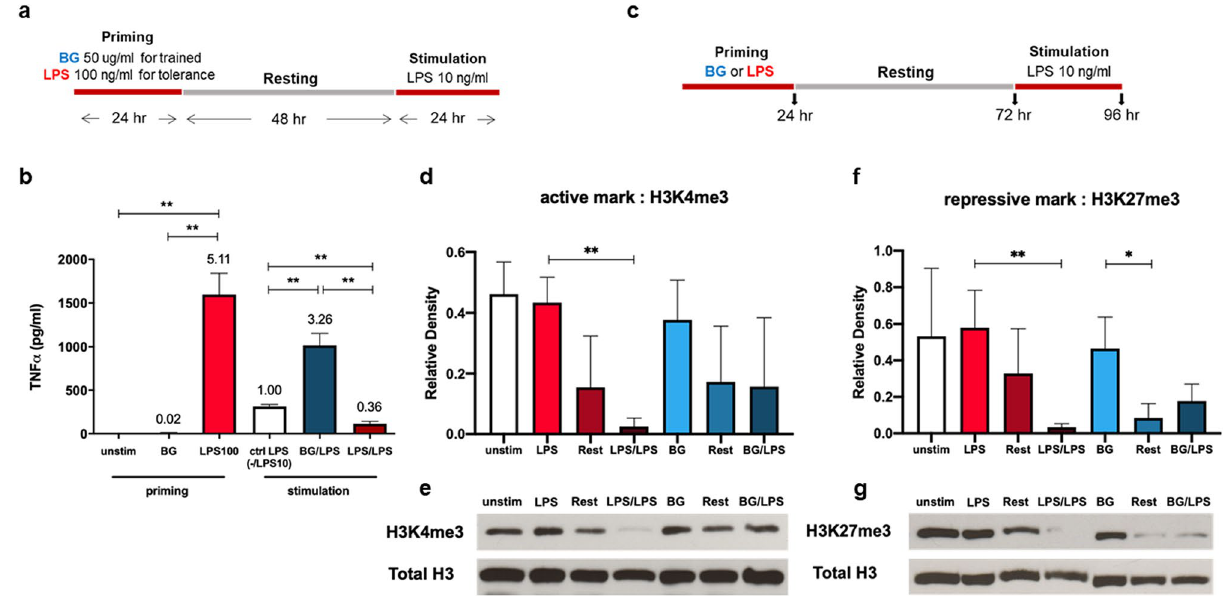
cells, BG-primed cells, or LPS-primed cells at 24 h and in LPS-stimulated naïve cells (crtl), LPS-stimulated BG-primed cells (trained) or LPS-stimulated LPS-primed cells (tolerant) after 24 h of stimulation. The relative fold changes were calculated by normalizing to the amount obtained from LPS-stimulated naïve BMMs (10 ng/ ml). ( c ) Protocol to induce BG-trained or LPS-tolerant macrophages using BMM and the indicated time for cell lysate collection. ( d – g ) Levels of H3K4me3 and H3K27me3 normalized to total histones in BMMs treated as indicated in ( c ) as detected by Western blot. *, **, and *** indicate significant differences compared by two-tailed unpaired t-tests at p < 0.05, p < 0.01 and p < 0.001,